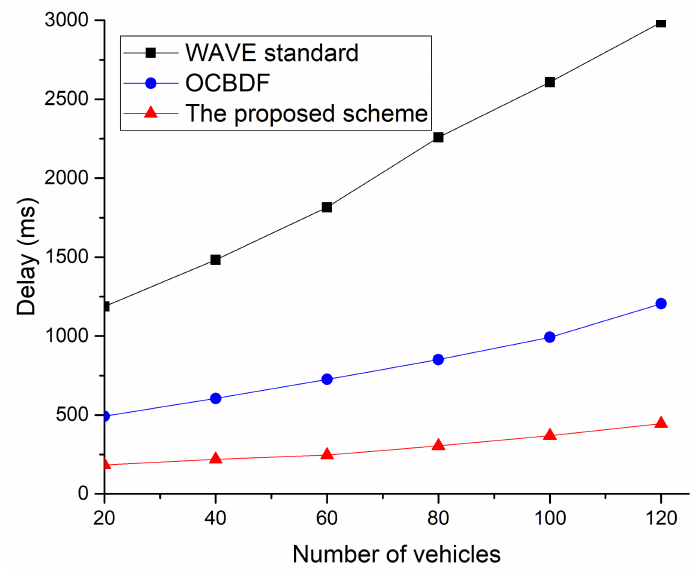
Figure 18. Delay as a function of the number of